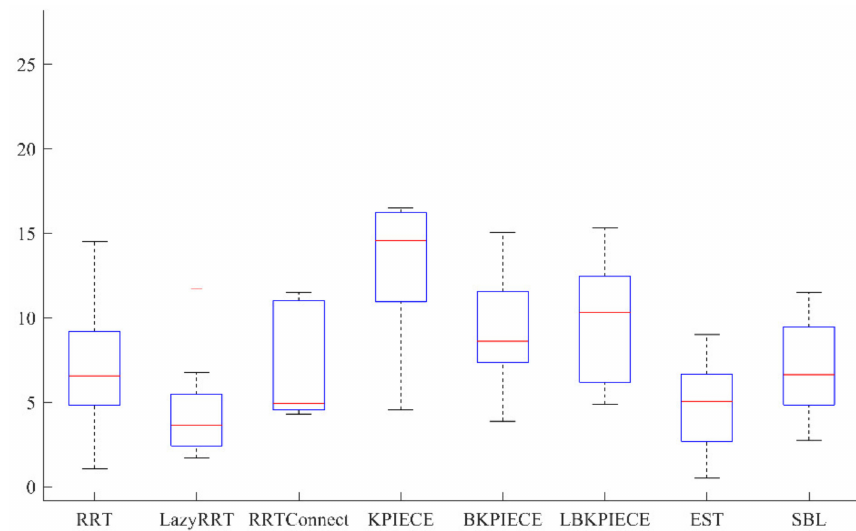
Figure 16. Path planning computation time (in seconds) of Prubot in test